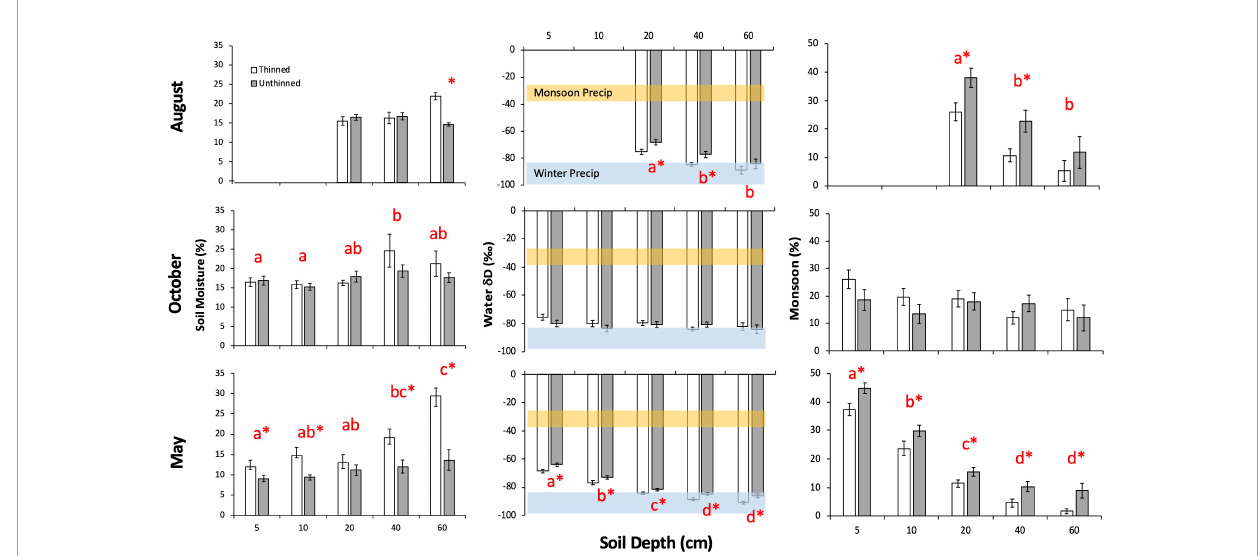
FIGURE1 Mean ( ± SE) soil moisture (left column) , soil water δ D (middle column) , and the monsoon contribution to soil water (right column) at the Fort Valley Experimental Forest near Flagstaff, AZ, USA. Sampling occurred in August 2013 (top row of panels) , October 2013 (middle row of panels) , and May 2014 (bottom row of panels) . Within each panel, asterisks denote a significant difference between thinned and unthinned treatments, and depths not sharing the same letter are significantly different. In the soil water δ D panels (middle column) , local monsoon (July through September; δ D = –31 ± 6) and winter (October through March; δ D = –91 ± 8) precipitation δ D values are shown in orange and blue bars, respectively (Kerhoulas et al., 2013). Data are missing from 5 and 10 cm depths in August due to complications with the cryogenic vacuum extraction